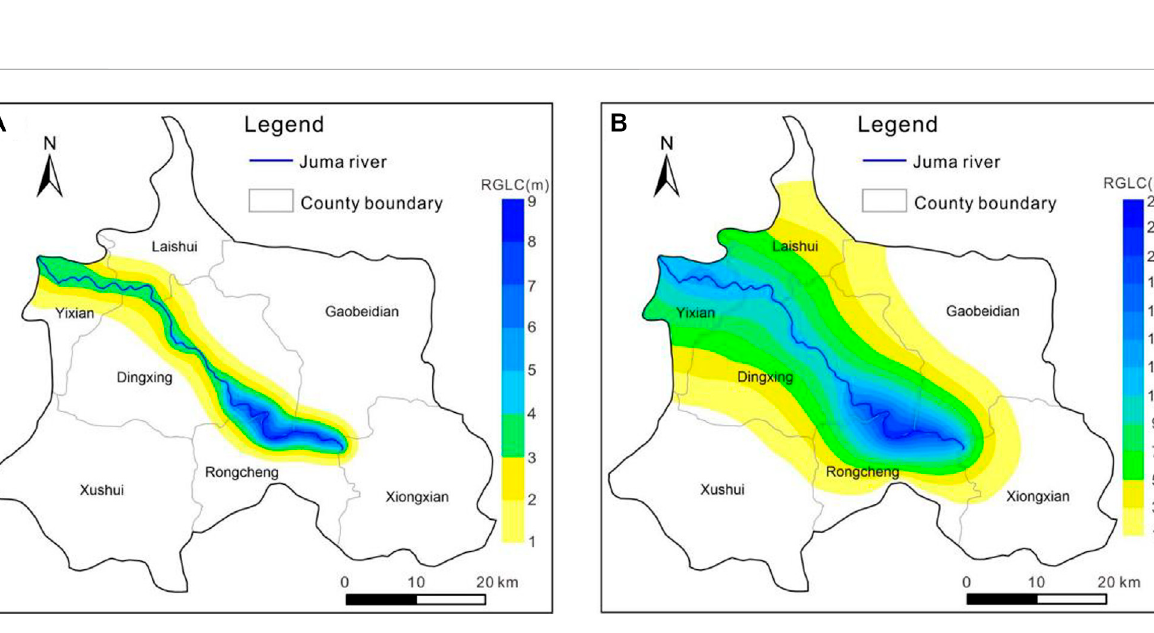
FIGURE 4 Comparison of the RGLC with and without river replenishment: (A) at the end of 2020 and (B) at the end of